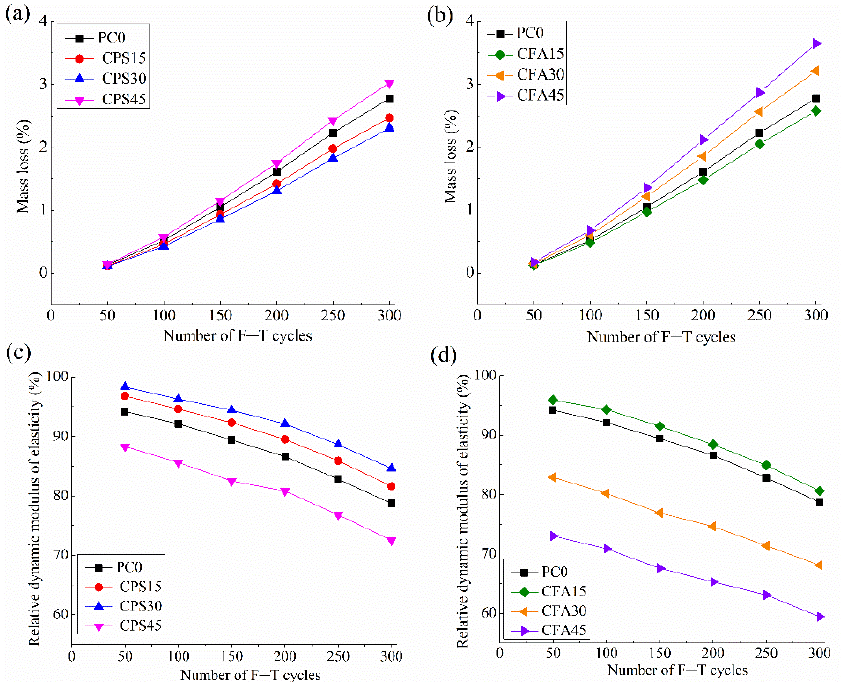
Figure 4. Frost resistance results of concrete hydrated at 180 days; ( a ) and ( b ) mass loss of FGPS concrete and fly ash concrete, ( c ) and ( d ) relative dynamic elastic modulus of FGPS concrete and fly ash concrete.